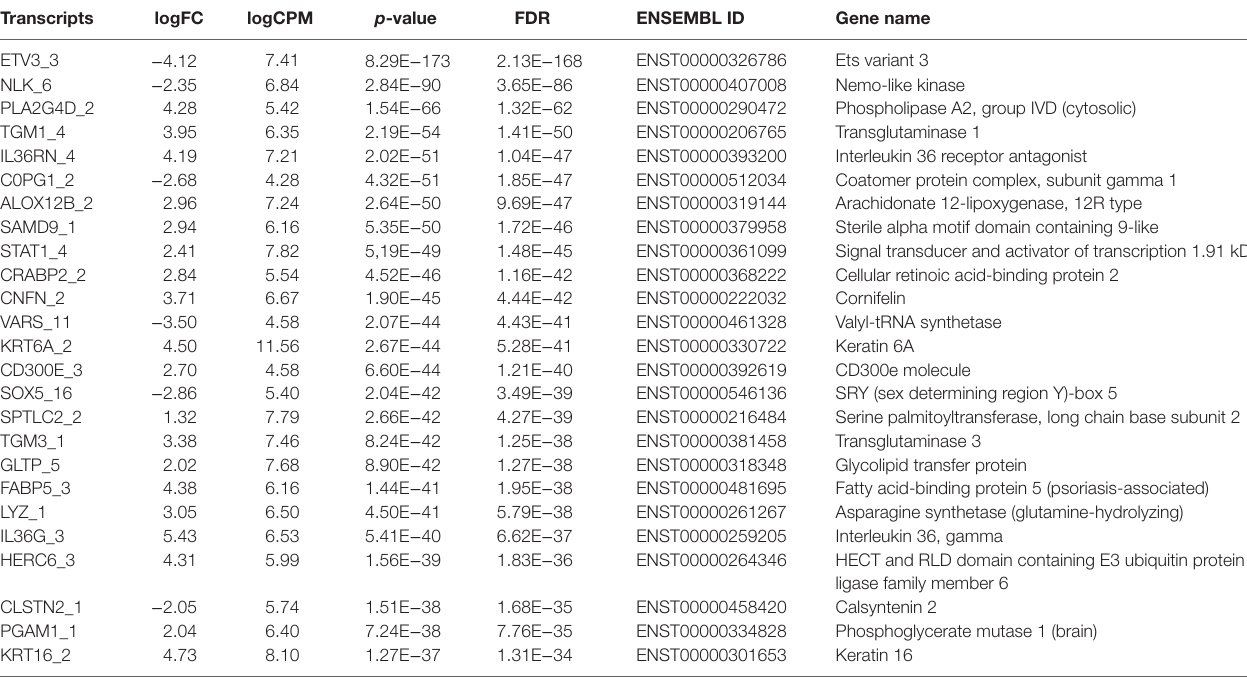
TaBle 2 | analysis of transcript isoforms in psoriasis, lP–c comparison, sorted by FDr value.